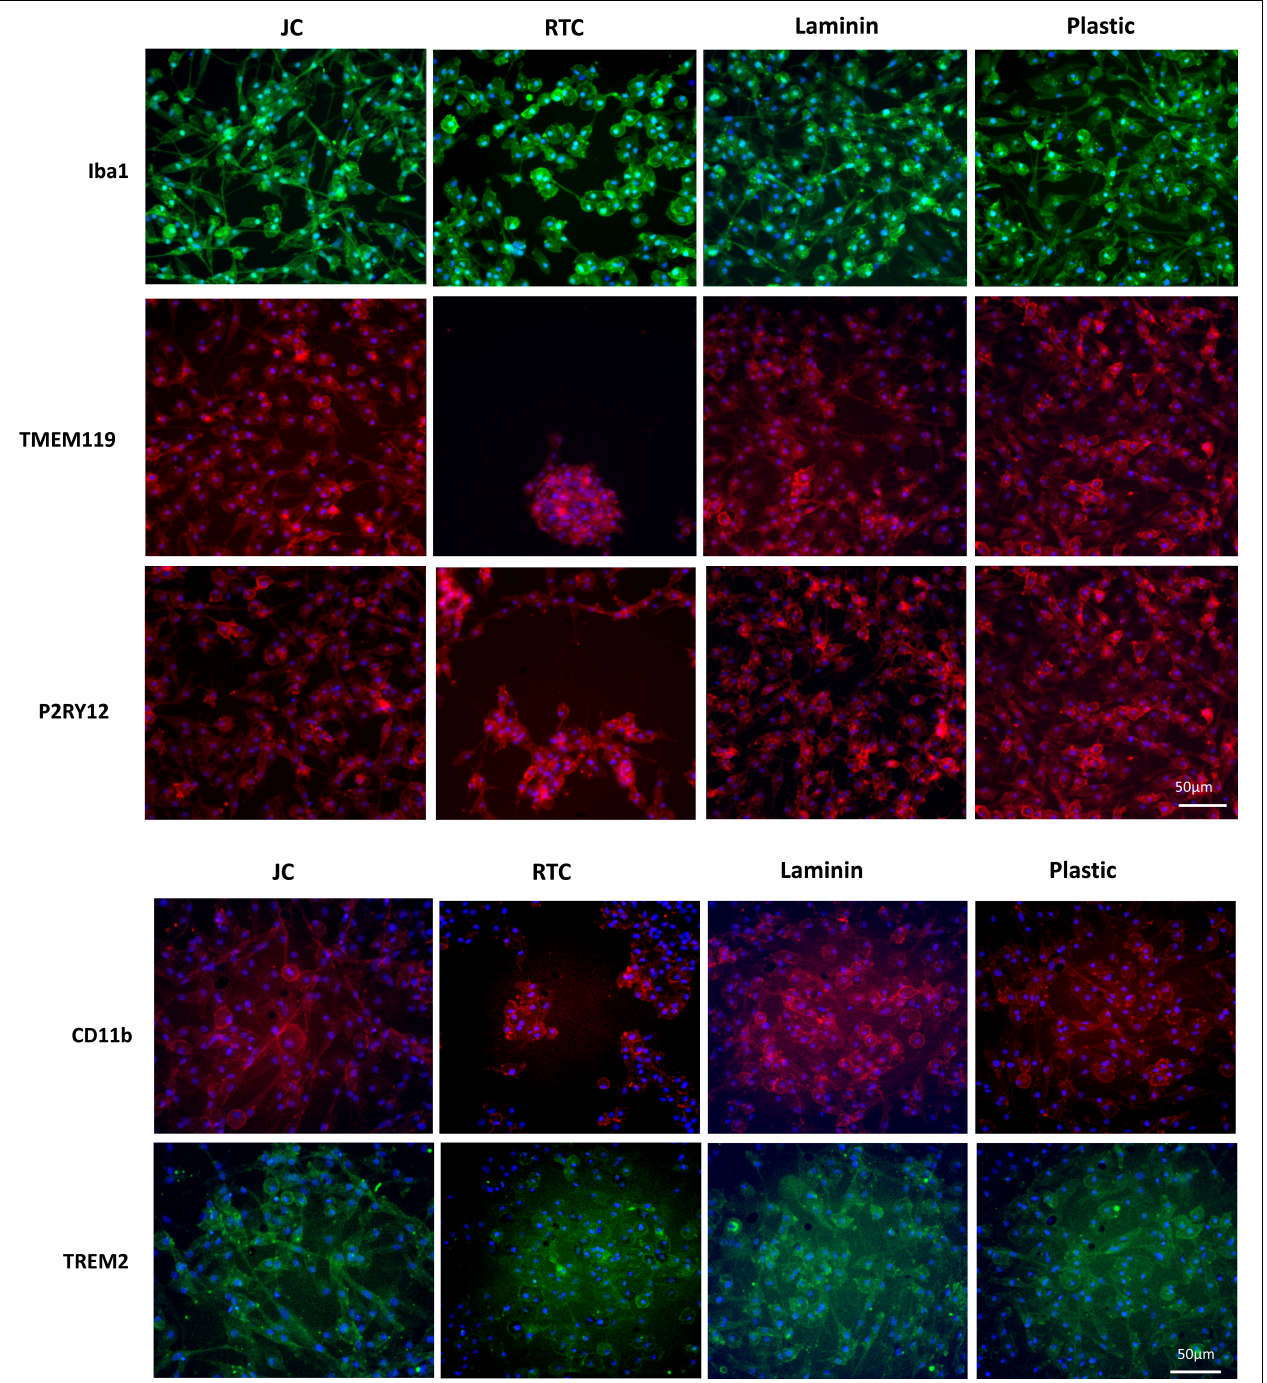
FIGURE 7 | Immunocytochemistry staining of typical microglia markers of iMGL cultured on Jellagen R (cid:13) (JFC), rat tail collagen I (RTC), laminin or TC plastic. Blue: DAPI, red/green: stain of interest. Scale bar = 50 µ m.